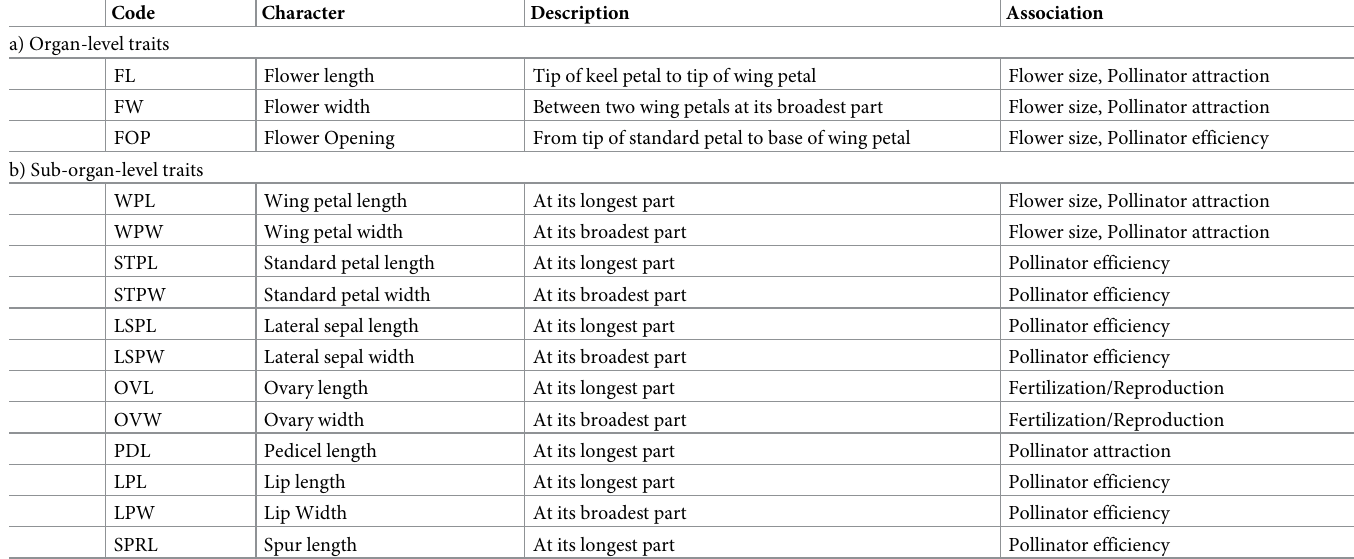
Table 1. List of morphological characters studied in populations of Impatiens species in the wild and in common garden experiments. Organ level traits, the three dimensional measurements of the flower made from fresh flowers and sub organ level traits indicate measurements quantified from dissected floral parts. All variables were measured in millimetre (mm)